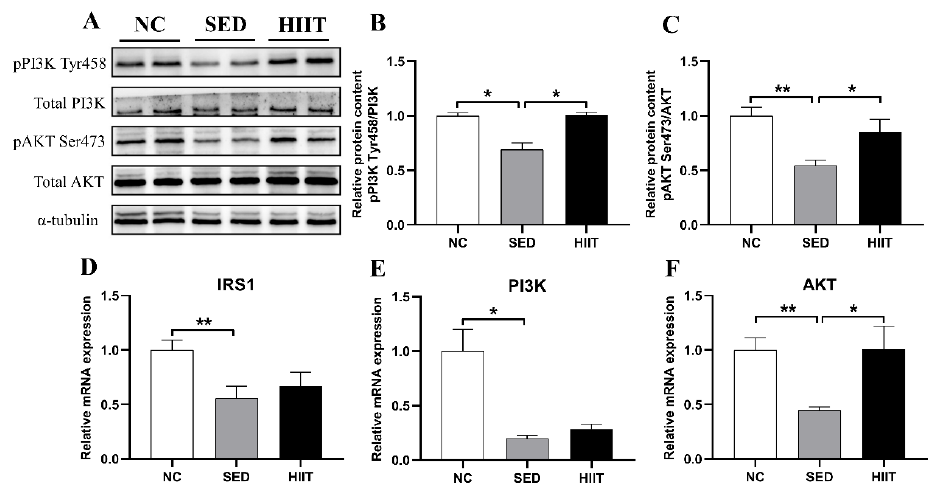
Figure 3. HIIT improves liver insulin resistance in T2DM mice. ( A ) Protein expression of pPI3K and pAKT and the internal control α -tubulin in the liver. ( B , C ) Quantification of the proteins described in ( A ) with normalization to the protein levels of α -tubulin (n = 4 per group). ( D – F ) The mRNA expression levels of IRS1, PI3K, and AKT (n = 8 per group). Values are mean ± SEM. * p < 0.05, ** p < 0.01.